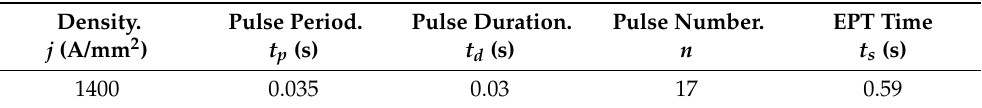
Table 2. Parameters in EPT.